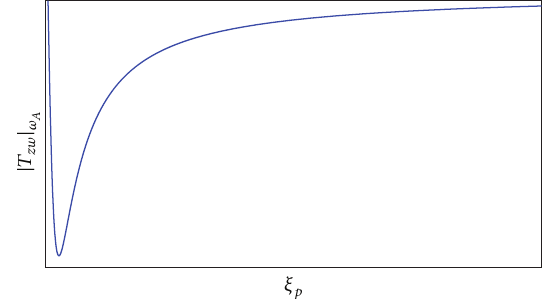
Figure 11: Dynamic amplification modulus at frequency 𝜔 𝐴 as function of the electrical damping 𝜉 𝑝 for a generic